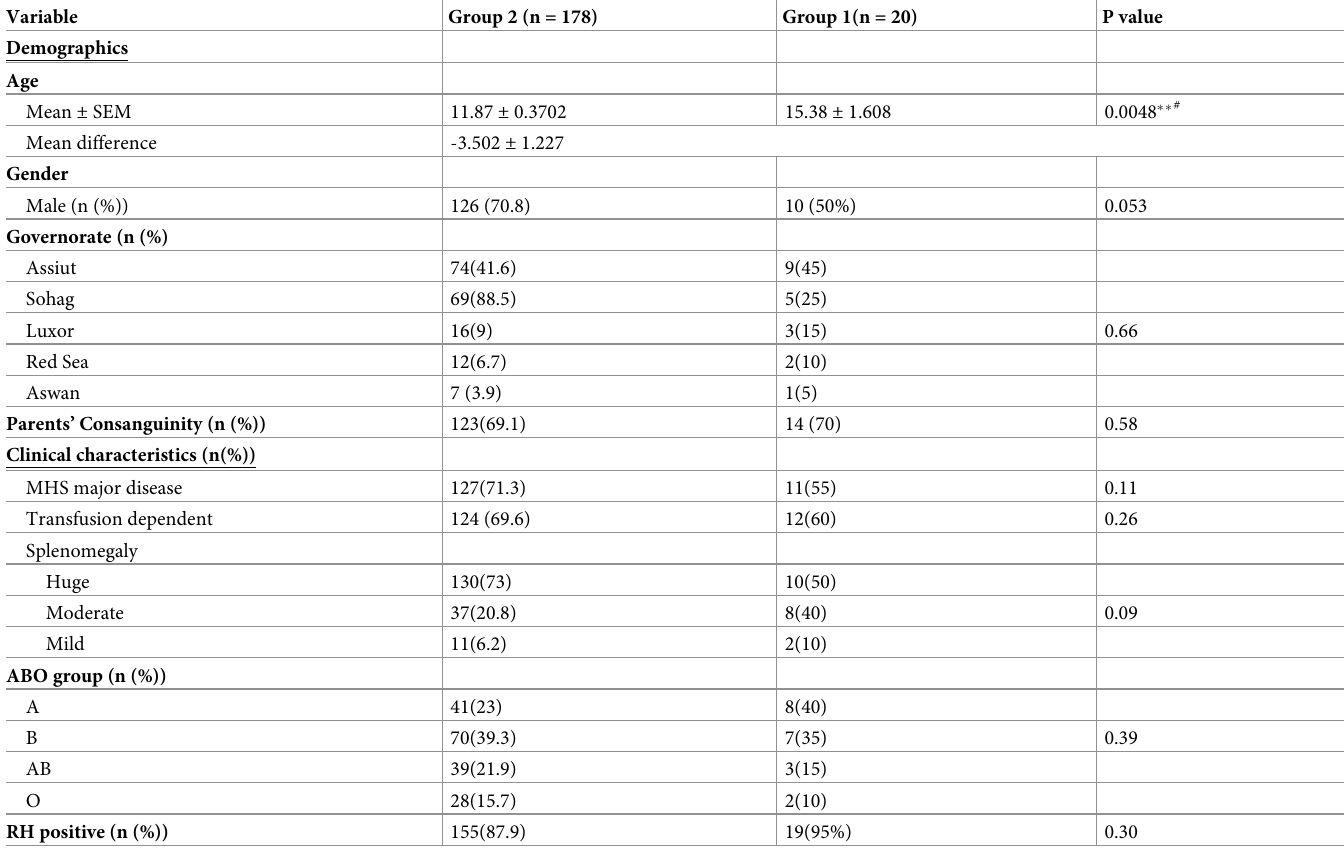
Table 1. Demographic and clinical characteristics of the study groups and their ABO and Rhesus